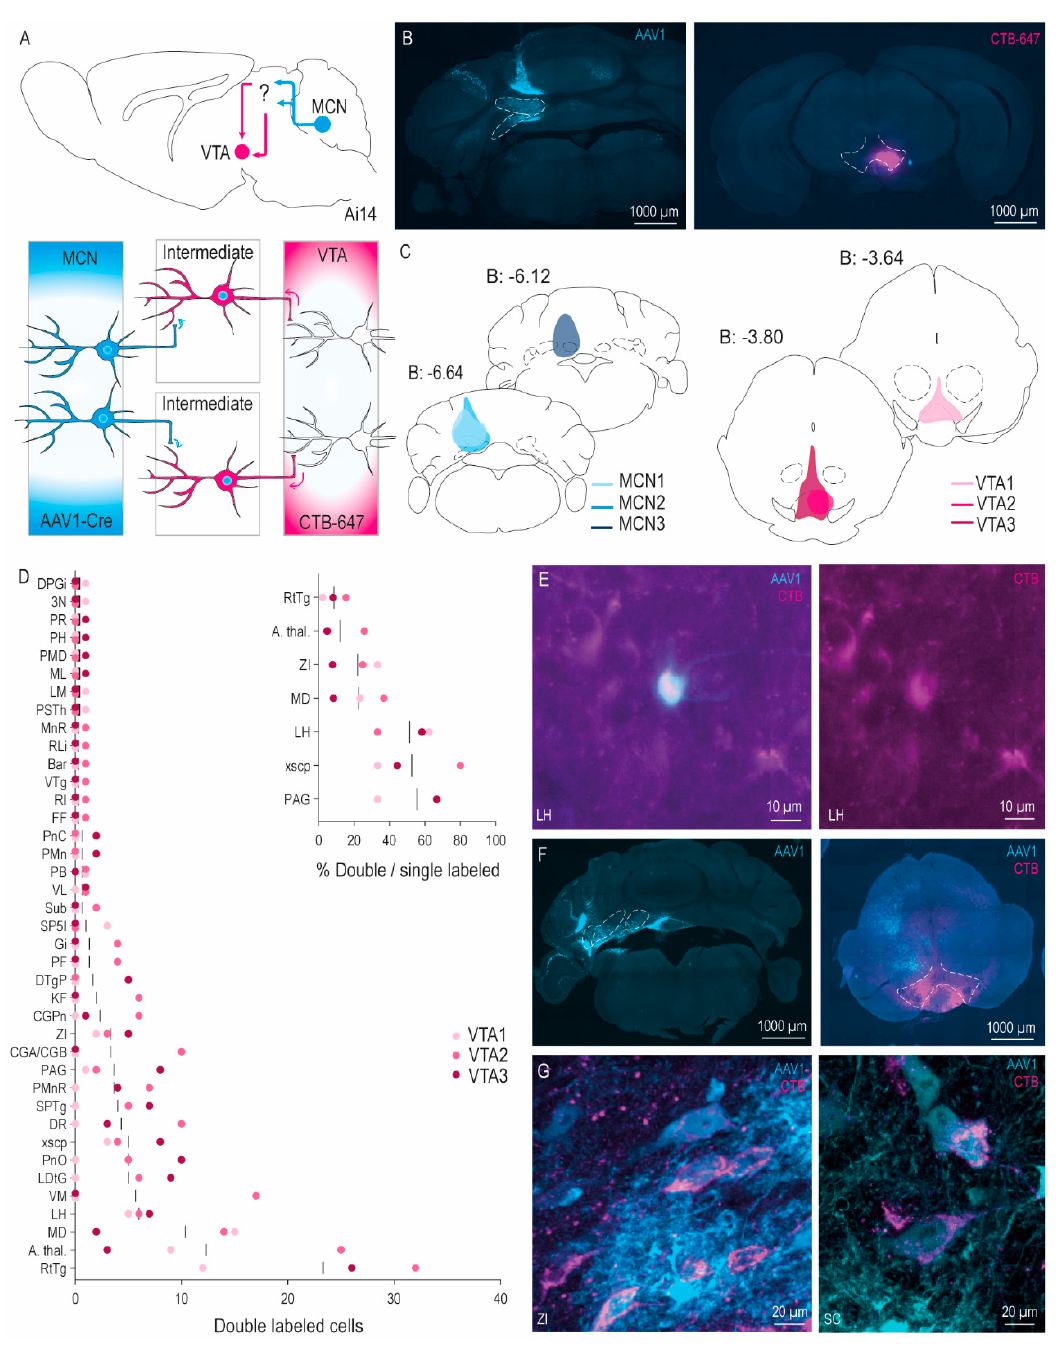
Figure 3. cATR tracing from MCN to VTA. ( A ) Schematic overview of cATR tracing approach from MCN to VTA. Blue: AAV1-Cre, Magenta: CTB-647. ( B ) Example injection spot in MCN (left) and VTA (right). ( C ) Schematic representation of the center of the injection spot of the MCN and VTA for each mouse ( n = 3). ( D ) Brain-wide analysis of the number of double labeled (AAV1+/CTB+) cells per nucleus per mouse following MCN injections. Vertical bars represent the average double labeled cells per nucleus. Inset shows percentage of double labeled cells over total AAV1+ cells per area in all areas where double labeled cells could consistently be identified. ( E ) Example of double labeled cell in LH. ( F ) Injection spots for MCN-INT-LCN experiments in CN ( left ) and VTA ( right ). Photo of VTA was taken slightly more rostral from center of injection. ( G ) Example photos of double labeled cells in ZI and SC in MCN-INT-LCN experiments. Abbreviations: 3N, oculomotor nucleus; A. thal, anterior thalamic areas; Bar, nucleus of Barrington; CGA/CGB, central gray, alpha and beta part; CGPn, central gray of the pons; CN; MCN-INT-LCN injections; DPGi, dorsal paragigantocel- lular nucleus; DR, dorsal raphe; DTgP, dorsal tegmental nucleus, pericentral part; FF, nucleus of the